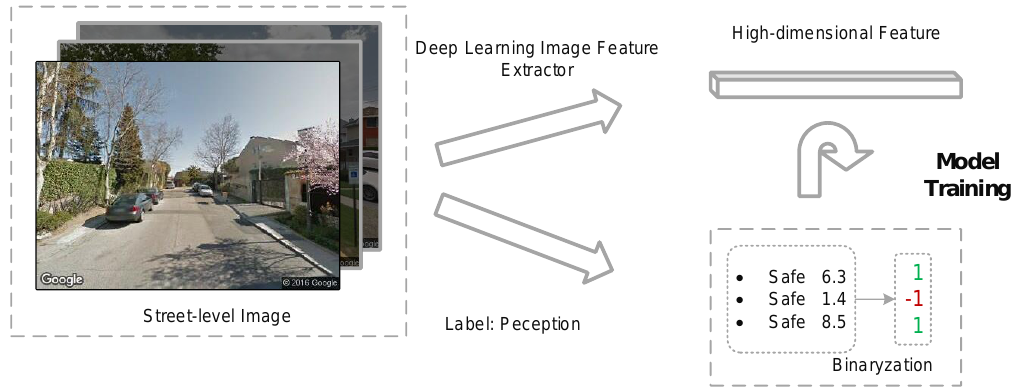
Figure 4. An overview: Modelling human perception to urban visual environment. First, we extract the image features using DCNN and annotate the image with a binary label. Second, an SVM classifier is trained to predict the human perception of a new region.